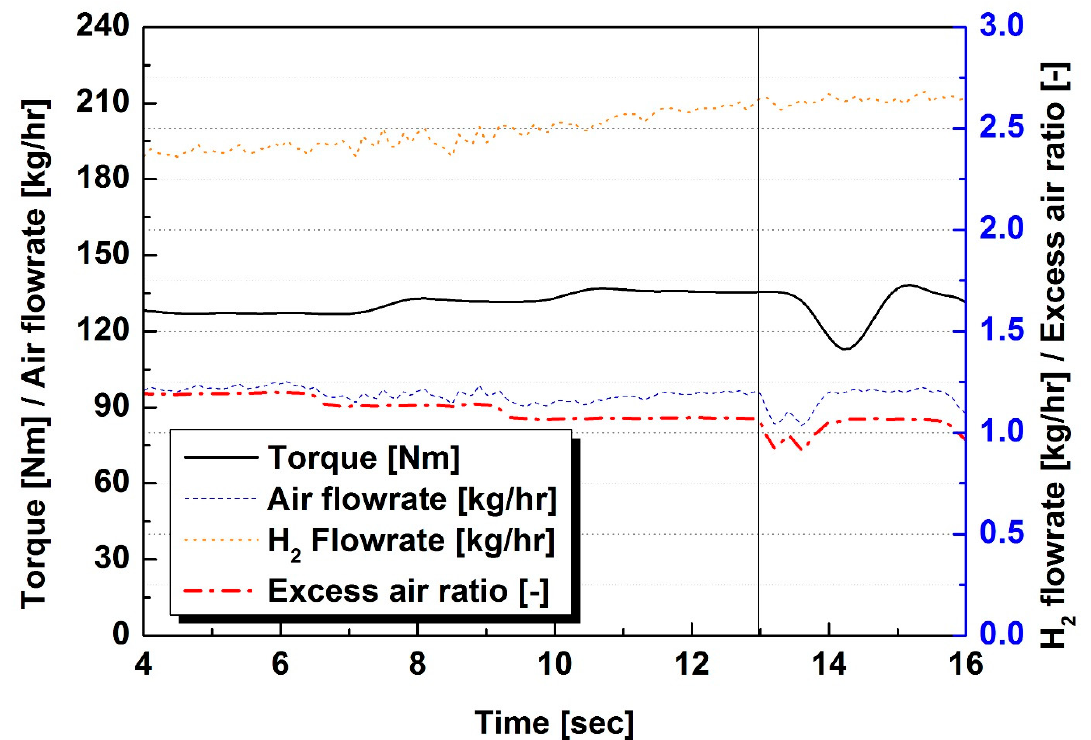
Figure 2. Torque, airflow, hydrogen flow, and excess air ratio changes in time with gradual increase in hydrogen fuel input.